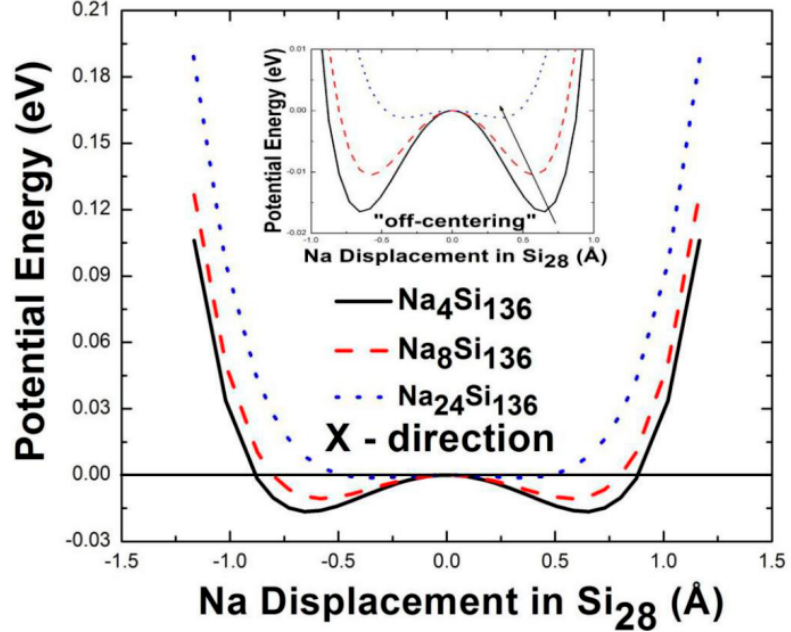
Figure 4. The calculated isotropic Mexican-hat shaped potential-energy curves for Na vibrations in the large 28-atom cages in the clathrate system Na x Si 136 ( x = 4, 8, 24). X represents the motion direction with respect to the Na atom.